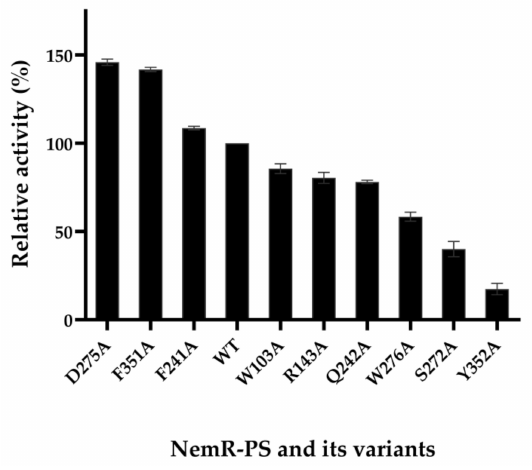
Figure 2. Crude enzyme activity of NemR-PS variants in alanine scanning. The assay mixture consisted of 100 µ g crude enzyme, 20 mM ( E / Z )-citral, 0.4 mM NADPH and 100 mM PIPES buffer (pH 7.0). The activity was measured in triplicate at 30 ◦ C by monitoring changes in the absorbance at 340 nm. The relative activity of 100% represents 0.34